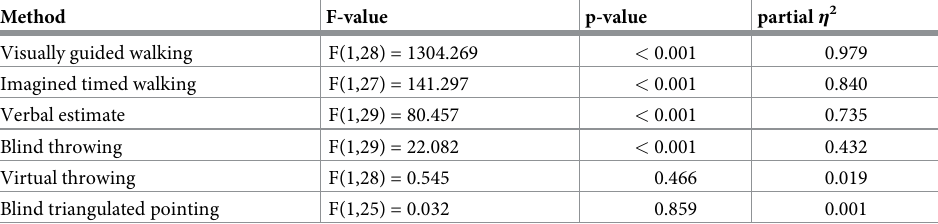
Table 2. Effect of translation gain for each method.